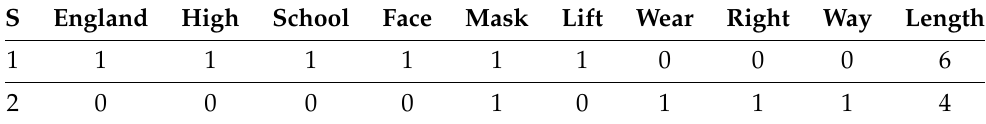
Table 6. Two sample tweets from the dataset are taken for Bag of Words features on preprocessed data.